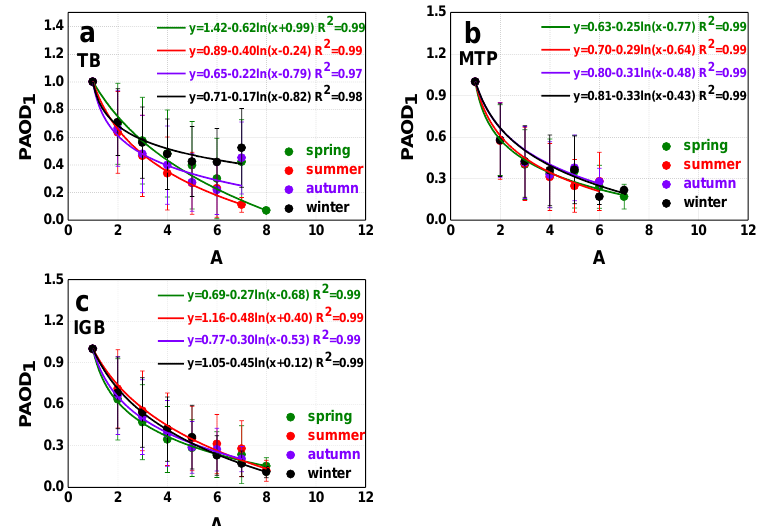
Figure 11. The correlations between PAOD1 and layer amount (A) over TP. ( a ) is for TB, ( b ) for MTP, and ( c ) for IGB.